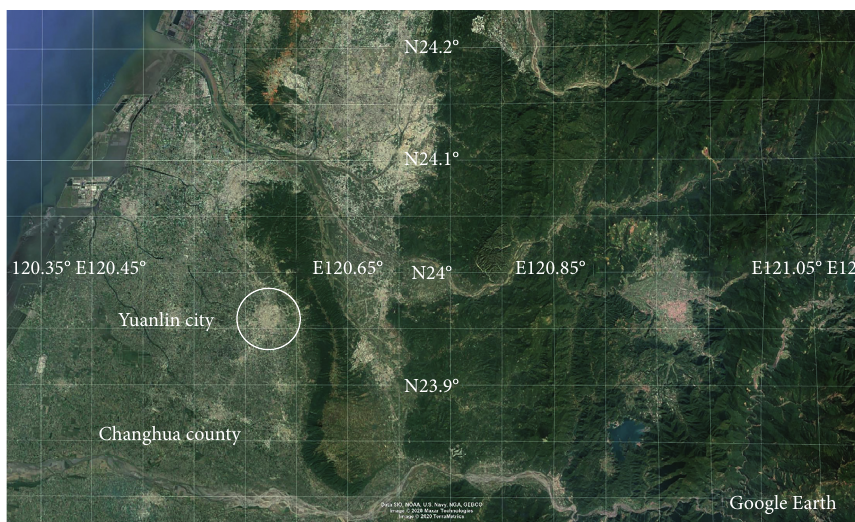
Figure 7: Location of Yuanlin City, Changhua County (from Google